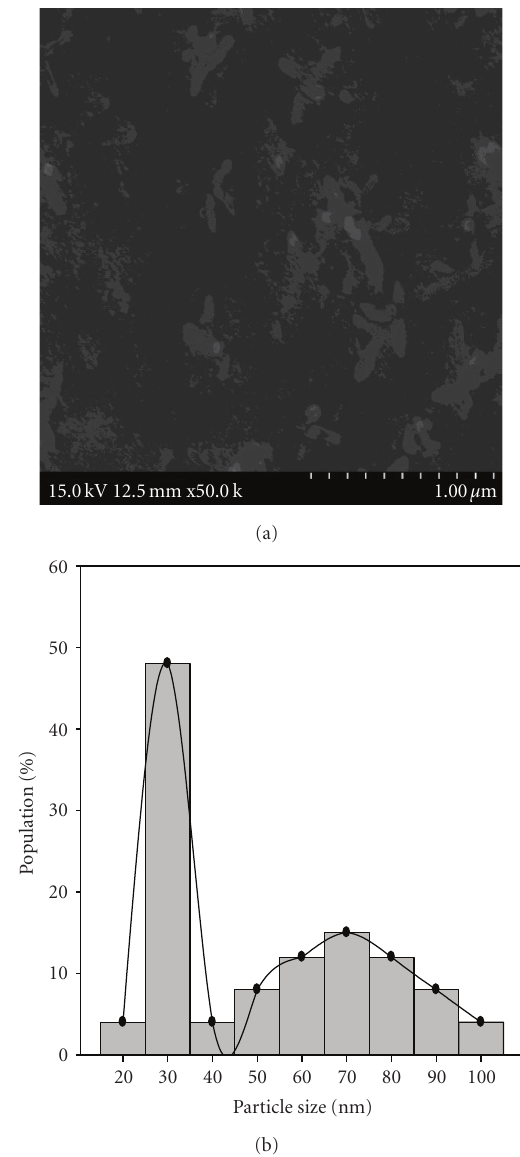
Figure 6: H-TTIP-TiO 2 thin film morphology after annealing at 500 ◦ C.